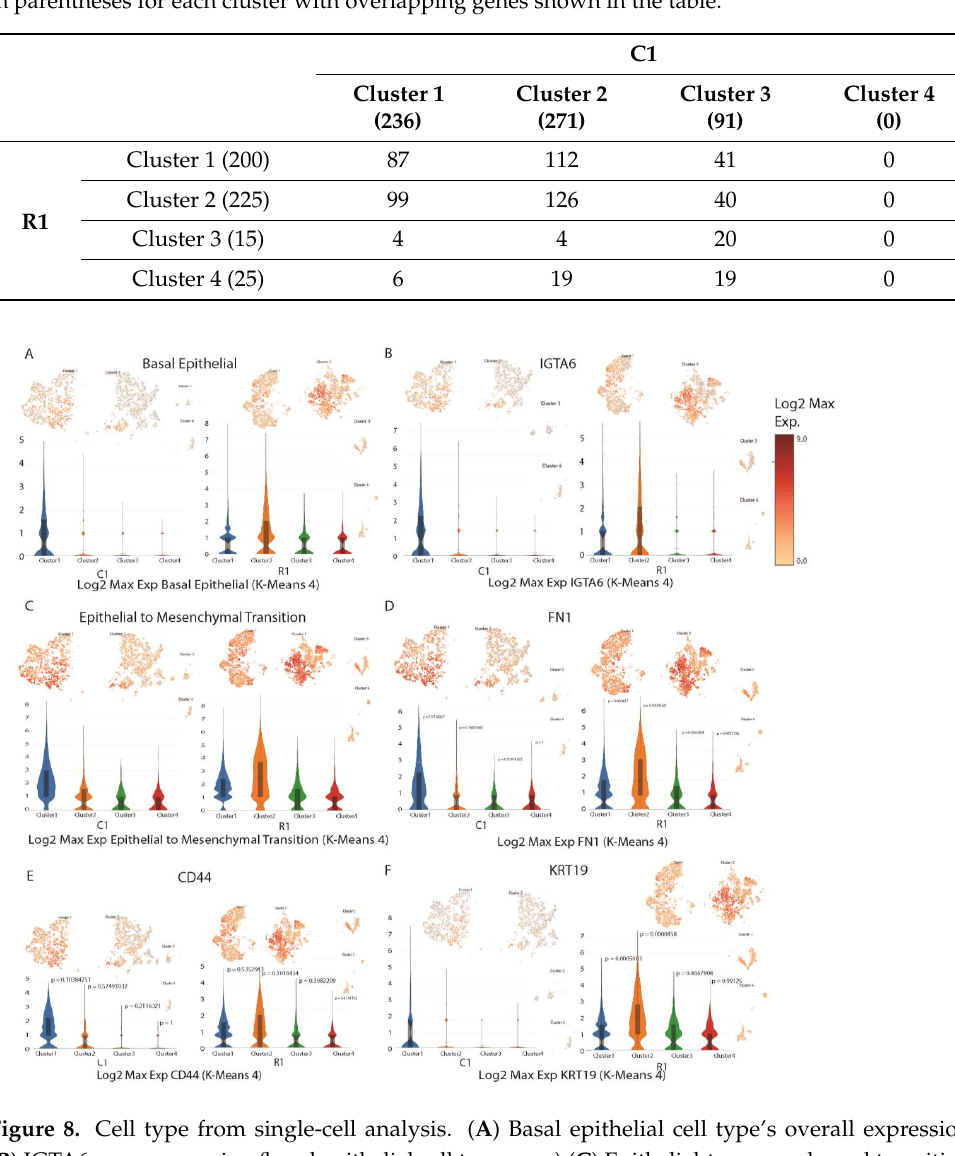
Table 1. Genes with p < 0.05 based on a single-cell K-means analysis. Genes for C1 and R1 are shown in parentheses for each cluster with overlapping genes shown in the table.